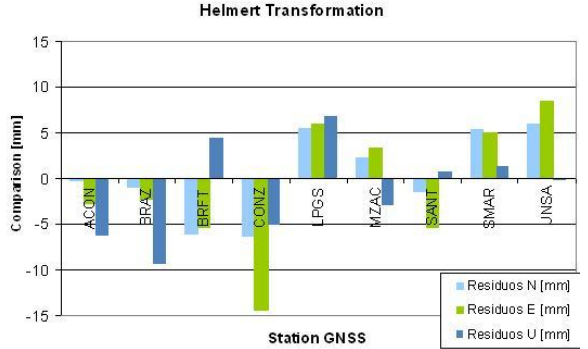
Figure 4. Helmert Transformation Fig. 4. Helmert Transformation.